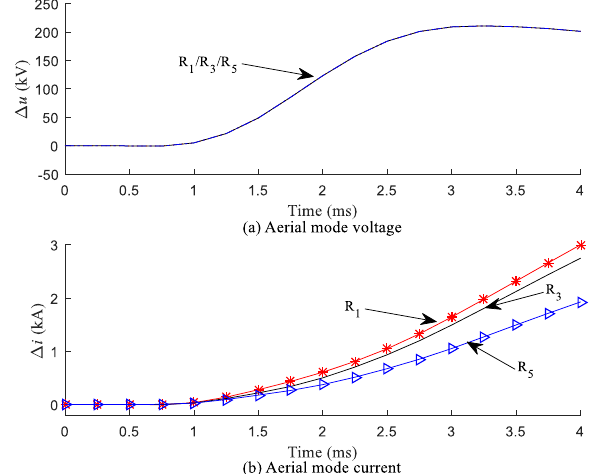
Figure 7. The aerial mode components that were detected by R 1 , R 3 , and R 5 for a fault at f 1 on busbar I: the ( a ) aerial mode voltage and the ( b ) aerial mode current.